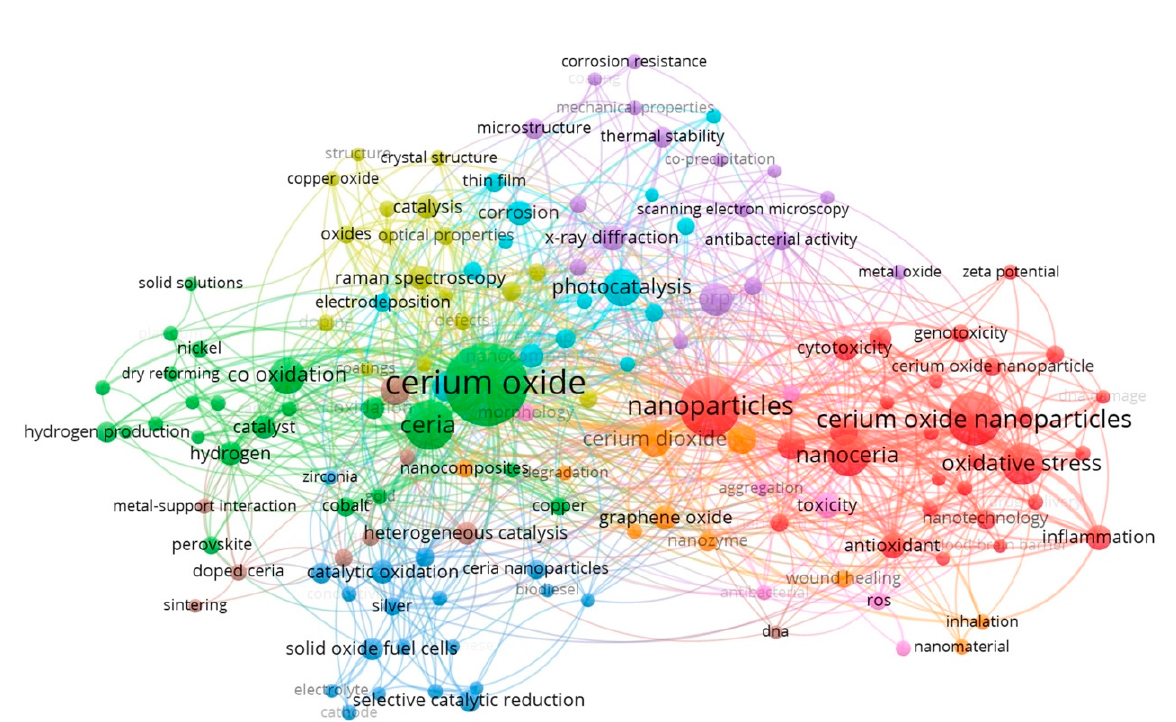
Figure 2. Network visualization map showing nine color-coded clusters produced using the VOSviewer and the WoS Database with the search “cerium oxide OR ceria OR nanoceria OR nano ceria”. The network analysis from 7862 publications and 144 author key words, from 1990 to 2020. The colours represent the clusters of keywords presented in Table 3. Access on the 17 September 2020.